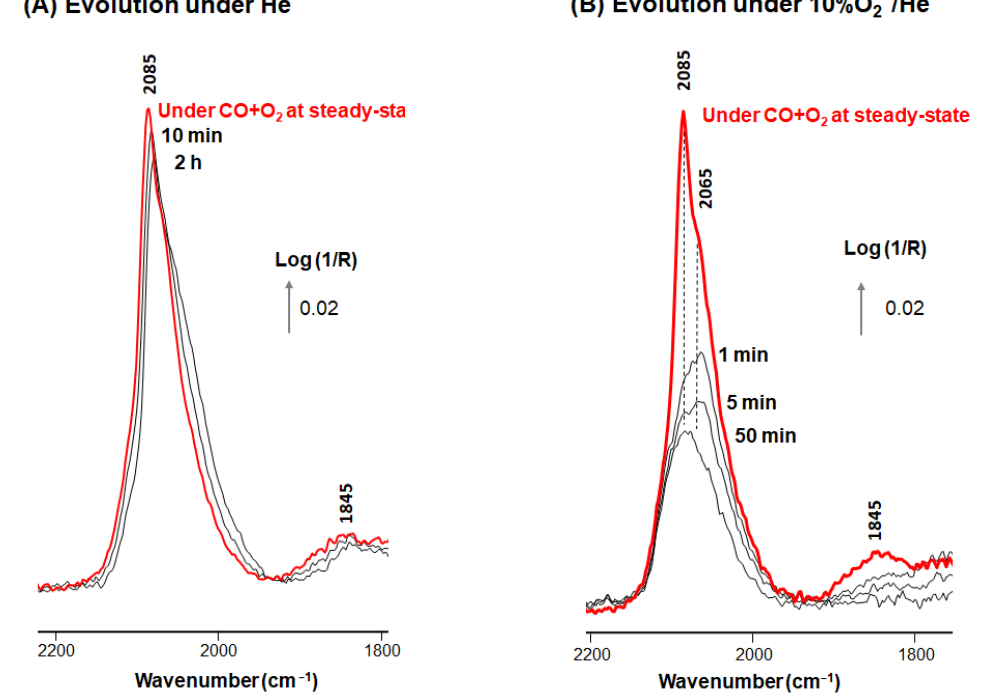
Figure 4. Evolution of DRIFTS spectra over Pt/Al 2 O 3 , recorded at 30 °C as a function of time under ( A ) He and ( B ) 10% O 2 /He. Total flow rate: 100 mL/min. The sample was previously left 15 min under 10% O 2 /He and then 15 min under 0.5% CO + 10% O 2 /He to reach steady-state (Red spectrum).